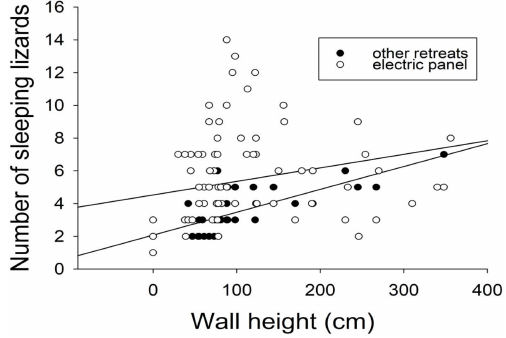
Figure 3. Relationship between wall height and number of sleep- ing rainbow lizards ( Agama agama ) in Port Harcourt city (southern Nigeria). The two regression lines respectively show lizards using electric panels as retreat sites and lizards using other retreat sites. For the statistical details, see the text.